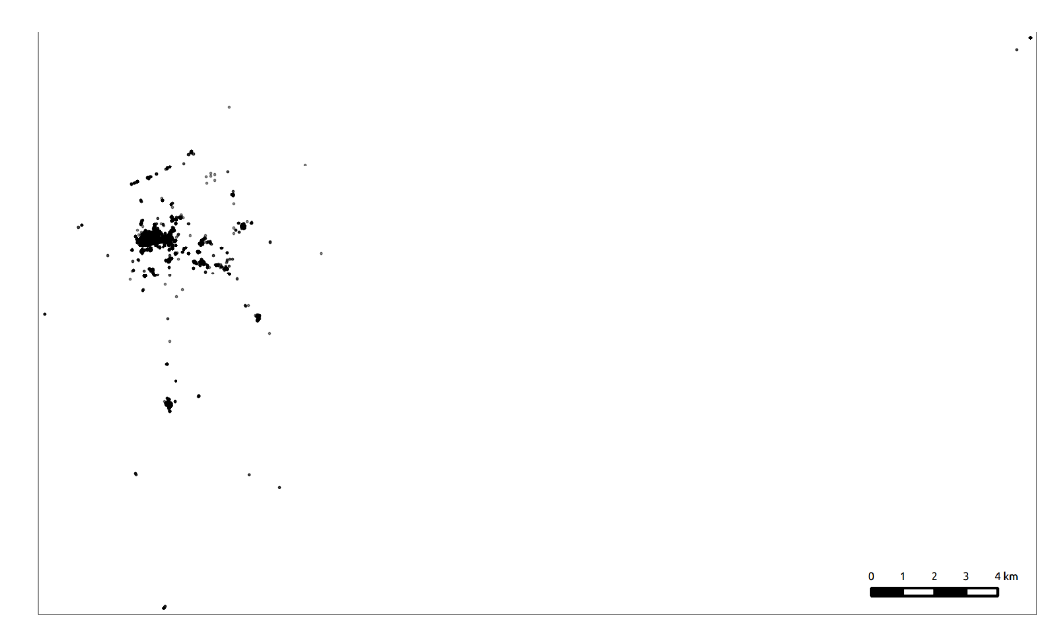
Figure 13. Sampling points at 25 May 2015 12:00:00-03. Source: the authors.